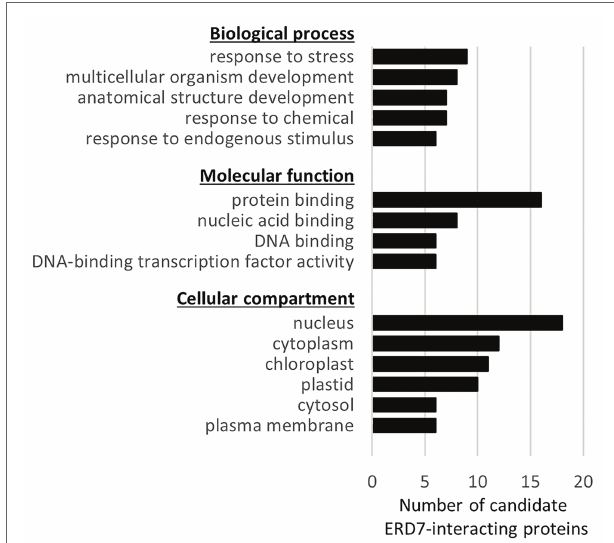
FIGURE 6 | Functional categorization, based on Gene Ontology (GO) terms, of candidate ERD7-interacting proteins identified in a Y2H screen. Each of the 36 Arabidopsis proteins identified in the Y2H screen using ERD7 as bait (refer to Supplementary Table 3 for a list of all of the candidate ERD7-interacting proteins) were assigned GO terms based on the functional categorization of genes using the GO Slim annotation search tool at TAIR. Shown for each GO category (i.e., “Biological process,” “Molecular function,” and “Cellular component”), is the number of candidate ERD7-interacting proteins with the assigned GO annotation that appeared in at least six or more